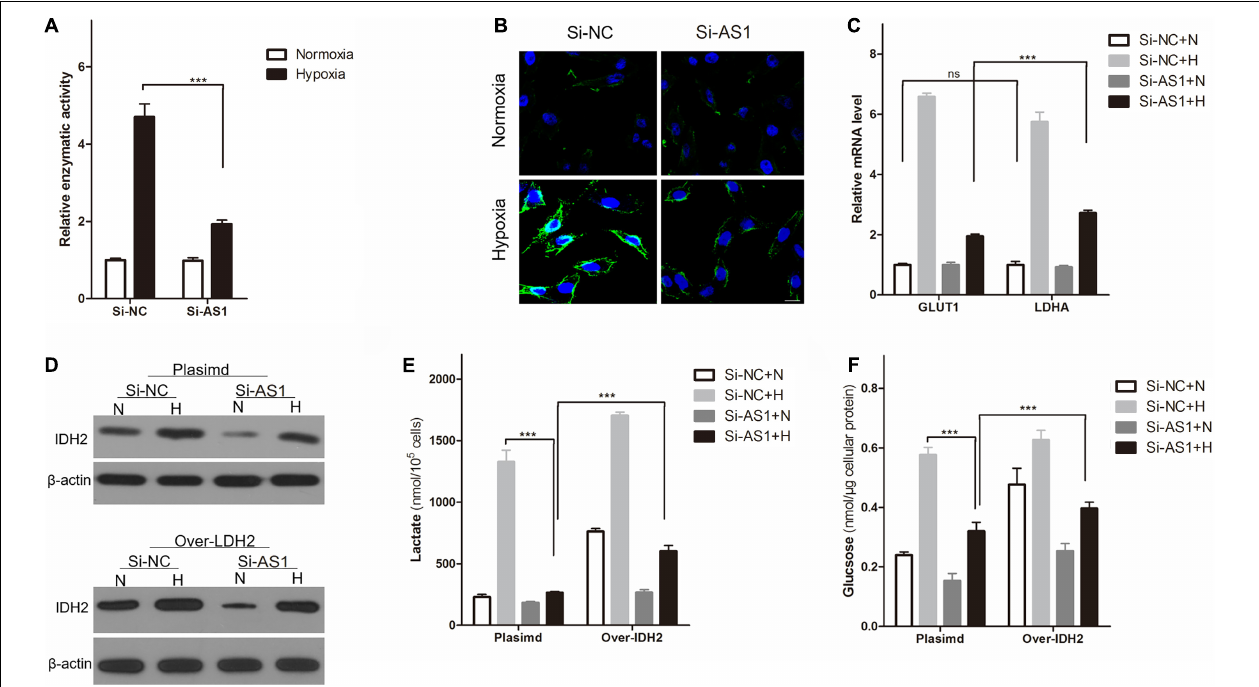
FIGURE 5 | OIP5-AS1 mediates the promoting effect of hypoxia on Warburg effect is IDH2 dependent. (A) Levels of LDHA enzymatic activity (A) , representative of GLUT1 protein expression images (B) , and levels of GLUT1 and LDHA mRNA (C) in Hela cells knocking down OIP5-AS1 or its control under normoxic or hypoxic conditions for 24 h. Data were shown as mean ± SD of three individual experiments. ns was P > 0.05, *** was P < 0.001, and P value was calculated by Student’s t test. (D) We established a Hela cells overexpressing IDH2 (Over-IDH2) and its control cells (Plasmid), and used western blot to detect the expression of IDH2 protein in Over-IDH2 or Plasmid Hela cells after knocking down OIP5-AS1. (E,F) Levels of lactate (E) in the culture medium and intracellular glucose (F) of Hela cells after culturing for 24 h under hypoxia. Data were shown as mean ± SD of three individual experiments. *** was P < 0.001 and P value was calculated by post hoc